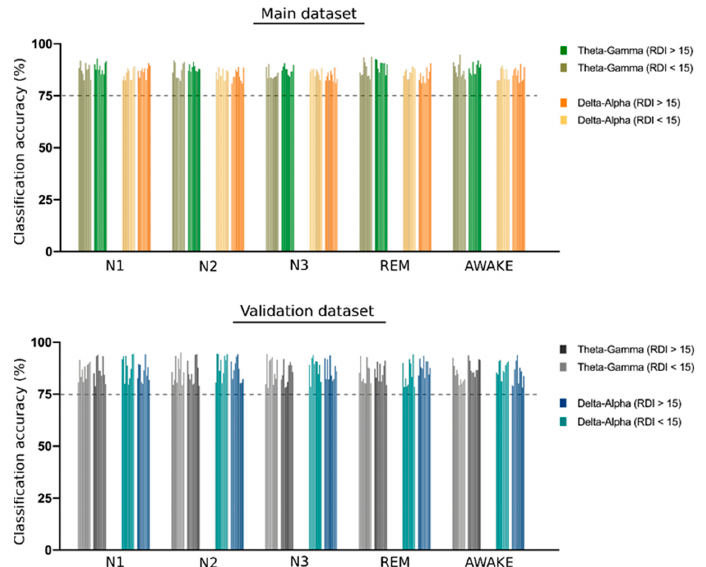
Figure 4. SVM classification of different sleep stages . The bar plot shows the support vector machine (SVM) classification accuracy of different sleep stages using the theta–gamma and delta–alpha cross frequency coupling (CFC) modulation indices. A group of 10 bars in each set represents the accuracy obtained for 10 ‐ fold cross ‐ validation. A dotted line is shown at 75% accuracy to emphasize the sig ‐ nificant degree of classification obtained for all CFC metrics used in the study. All the accuracy values are presented in the Supplementary Table S2. In addition, we were able to predict, using SVM, the RDI and the Epworth Sleepiness Scale (ESS) in different sleep stages with significant accuracy (more than 75%) using the CFC ‐ MI in both couples of frequency bands. The theta–gamma CFC was able to signifi ‐ cantly predict the RDI and ESS in NREM (N2 and N3) sleep stages. The delta–alpha CFC in the REM sleep stage was able to significantly predict RDI, and the delta–alpha CFC in awake stages was able to significantly predict ESS. The details of all predictions are shown in Figure 5.